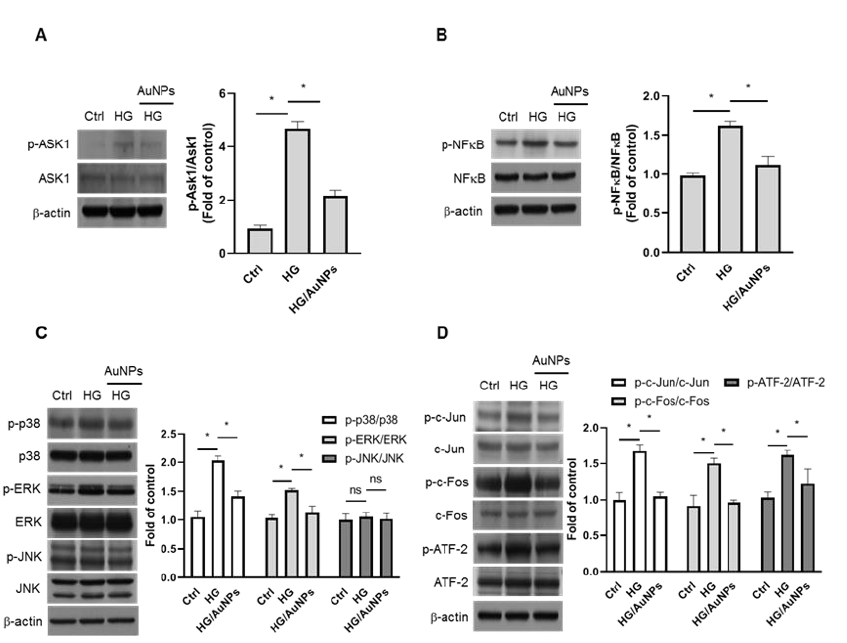
Figure 5. Effect of GA – AuNPs on levels of phosphorylated ASK1 ( A ), NF κ B ( B ), MAPKs ( C ), and c-Jun/c-Fos/ATF-2 ( D ) in high glucose-treated CCD-966SK cells. The cells were pretreated with 10 μg/mL for 1 h, and then incubated with 30 mM glucose for 24 h. ( Left panel ) Western blot analyses. ( Right panel ) Quantification of protein expression from Western blot analyses (* p < 0.05; NS, statistically insignificant).